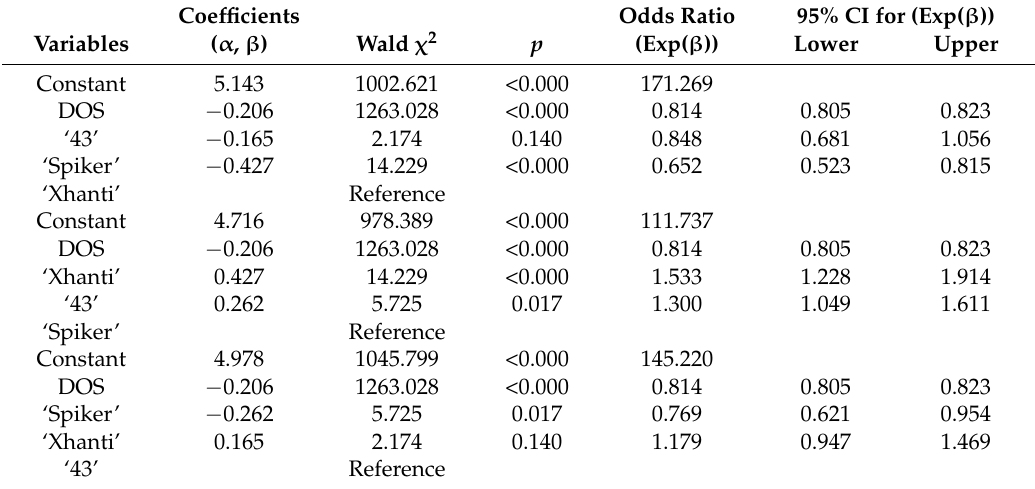
Table 4. Estimation of multiple logistic regression parameters for Tribelli XL ® pepper cultivars (‘43’, ‘Spiker’, and ‘Xhanti’) and number of days of storage (DOS) as factors influencing the probability of marketability.